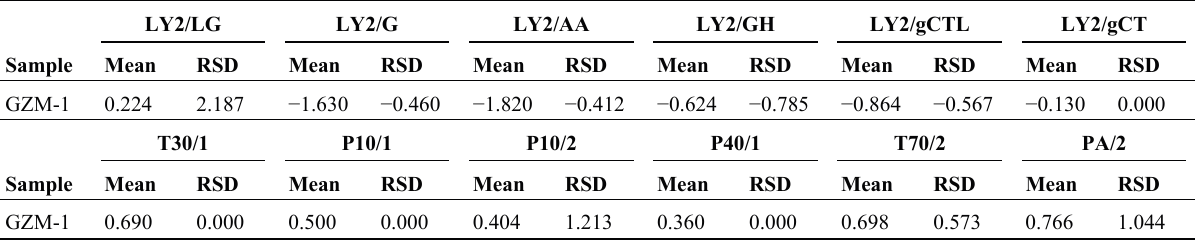
Table 5. Repeatability for sample